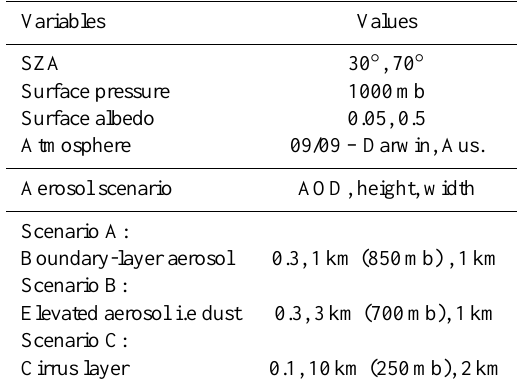
Table 2. Geophysical parameters used for the retrieval simulations. The aerosol profiles are set up as a Gaussian-shaped distribution for the given value of AOD, height and width with approximate pressure